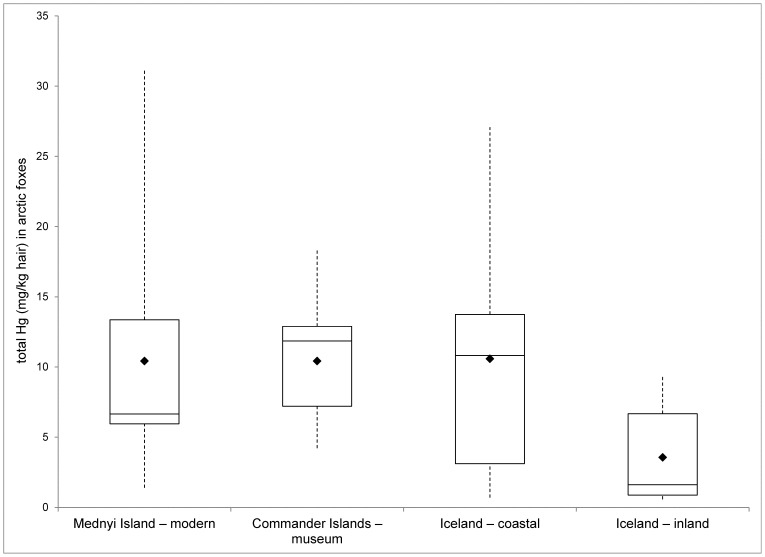
Levels of THg (mg/kg d.w.) in hair of arctic foxes originating from different ecotypes.Box plots indicate median (solid line) and mean (black diamond) of the THg values. The ranges of values are shown as dashed lines.